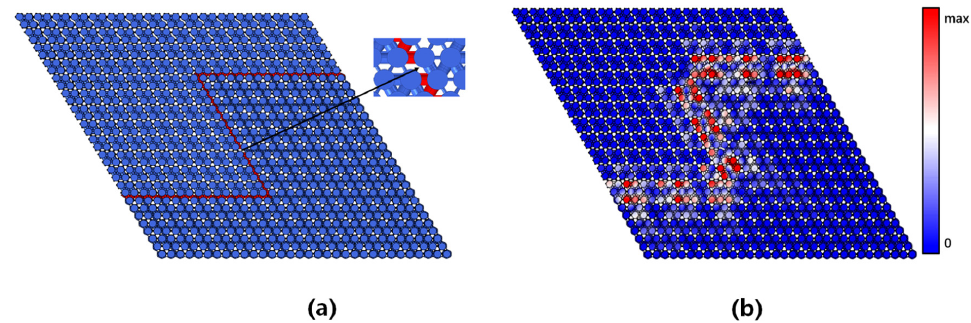
Figure 7. ( a ) Schematic diagram of a Z-shaped waveguide with a defect (an inter-coupling pillar is deleted); ( b ) Topological transport of elastic waves in the Z-shaped waveguide with a defect.